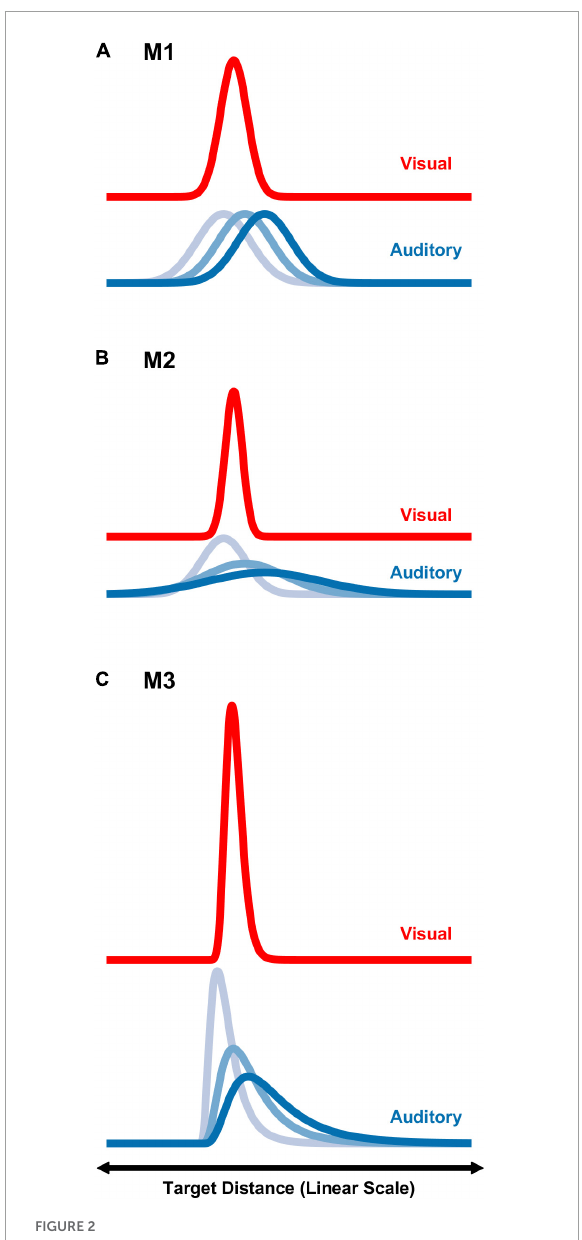
FIGURE2 Graphical depictions of the three modeling strategies, M1–M3 (A–C) , on a linear distance scale. For each strategy, distributions associated with a visual target at 1.5 m, and auditory targets at 1.5, 3, and 4.5 m are shown. See text for additional